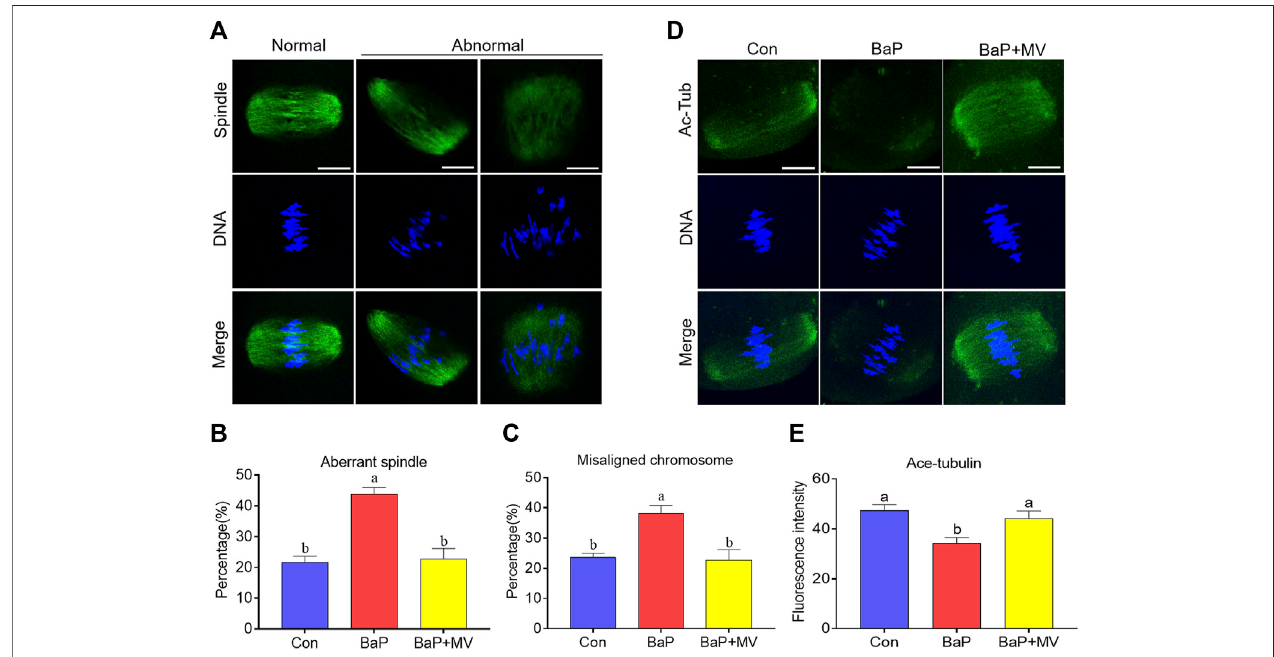
FIGURE 2 | Effects of MV on spindle assembly, chromosome alignment and α -tubulin acetylation in the oocytes of BaP-exposed mice. (A) Representative images of spindle morphology and chromosome alignment in oocytes. (B) Quanti fi cation of the disorganized spindle rates in the Con, BaP and BaP + MV groups. (C) Quanti fi cation of the misaligned chromosome rates in the Con, BaP and BaP + MV groups. (D) Representative images of acetylated α -tubulin (Ac-Tub) in Con, BaP and BaP + MV oocytes. (E) Quanti fi cation of the fl uorescence intensity of acetylated α -tubulin in the Con, BaP and BaP + MV groups. Scale bar (cid:2) 25 μ m. The data are presented as the mean ± SEM. a-b Means not sharing a common superscript are signi fi cantly different ( p < 0.05).